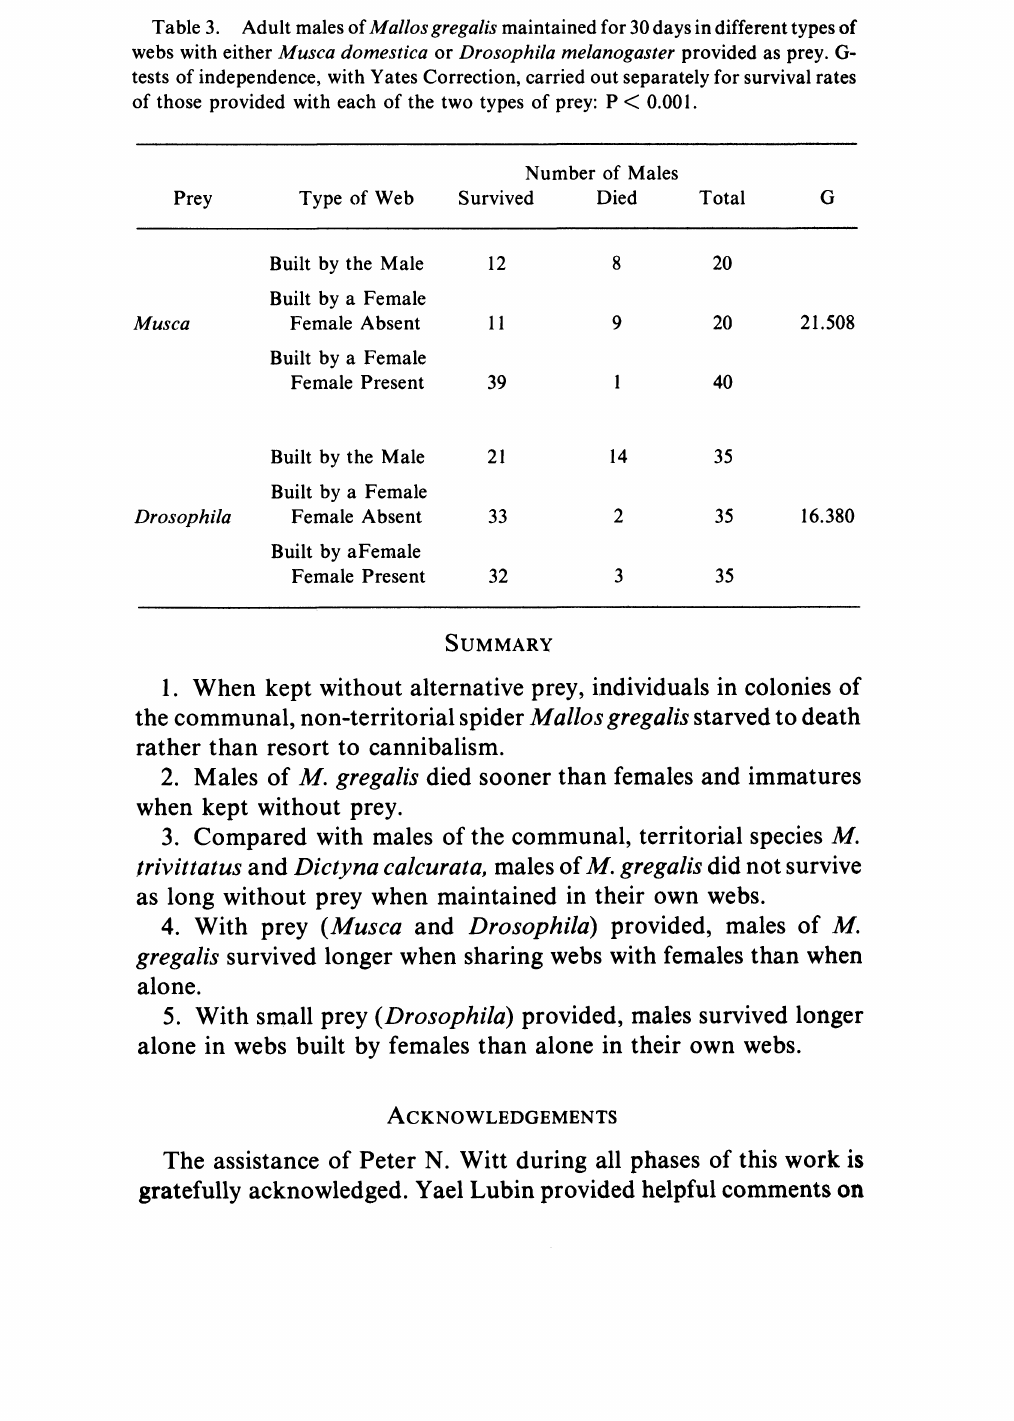
Table 3. Adult males of Mallos gregalis maintained for 30 days in different types of webs with either Musca domestica or Drosophila melanogaster provided as prey. G- tests of independence, with Yates Correction, carried out separately for survival rates of those provided with each of the two types of prey: P <